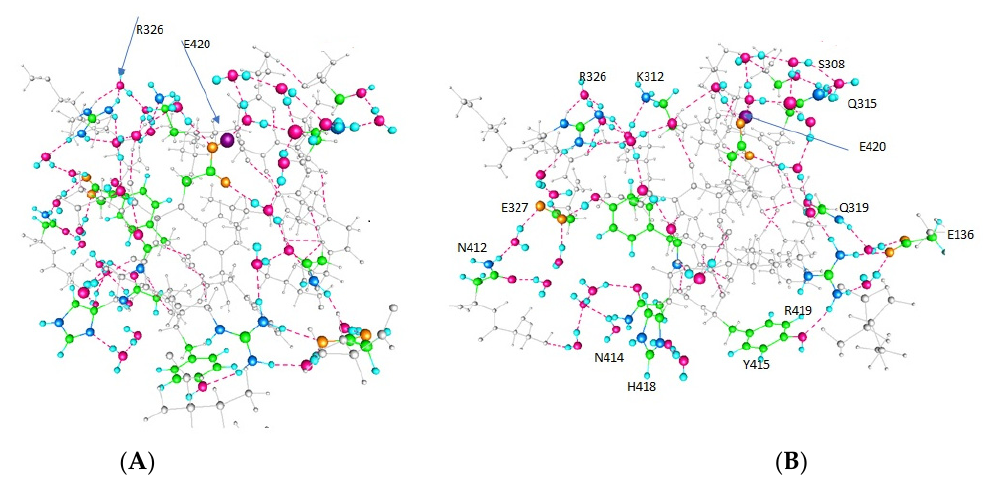
Figure 3. As in Figure 2, the key residues are labeled in ( B ), and the two paths, plus the crossover, can be seen by following the colored residues. The color code is the same, and the arrows again indicate the position of the two mobile protons (in ( A ) R326 is indicated; that residue is always protonated, but is indicated here as well). Rotation from ( A ) to ( B ) is as in Figure 2. This is one of the two low energy configurations, so this arrangement is considered to be part of the actual pathway.